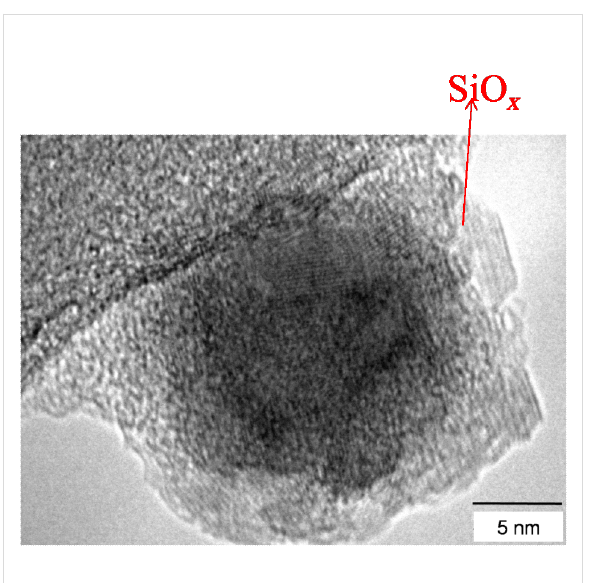
Figure 2: Transmission electron microscope image of Fe nanoparti- cles (dark contrast) coated with a thin SiO x layer (brighter